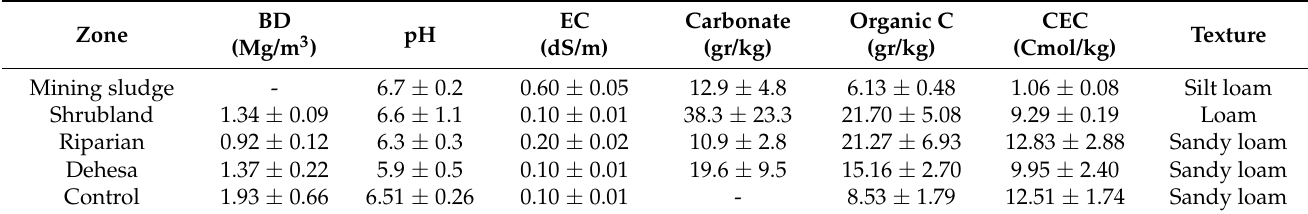
Table 1. Physical—chemical characteristics of the soils and sludge collected at the San Rafael mine. Mining sludge (n = 3), shrubland (n = 4), riparian (n = 12), dehesa (n = 21), control (n = 3).